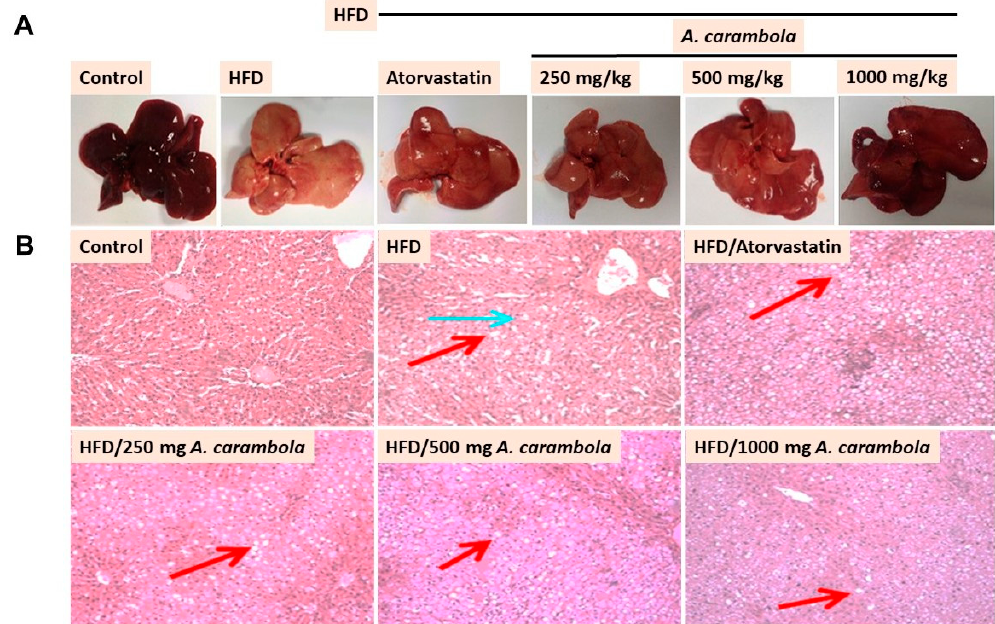
Figure 4. Effect of MEACL on rat liver gross and histology of HFD-induced hyperlipidemic rats as assessed by hematoxylin and eosin (H&E) staining. ( A ) Gross appearance of liver, ( B ) microscopic appearance of liver for normal control, hyperlipidemic control (severe macrovesicular steatosis, severe coagulation necrosis of hepatocyte, and severe cholestasis), and HFD-fed rats treated with atorvastatin (macrovesicular steatosis, lobular inflammation with multiple small foci, and mild cholestasis), 250 mg/kg MEACL (macrovesicular steatosis, lobular inflammation with multiple small foci, and mild cholestasis), 500 mg/kg MEACL (macrovesicular steatosis, lobular inflammation with multiple small foci, and mild cholestasis), and 1000 mg/kg MEACL (macrovesicular steatosis, lobular inflammation with few small foci, and no fibrosis or cholestasis). 100X magnification. Red arrow indicates macrovascular steatosis, and blue arrow indicates the coagulation necrosis of hepatocytes.